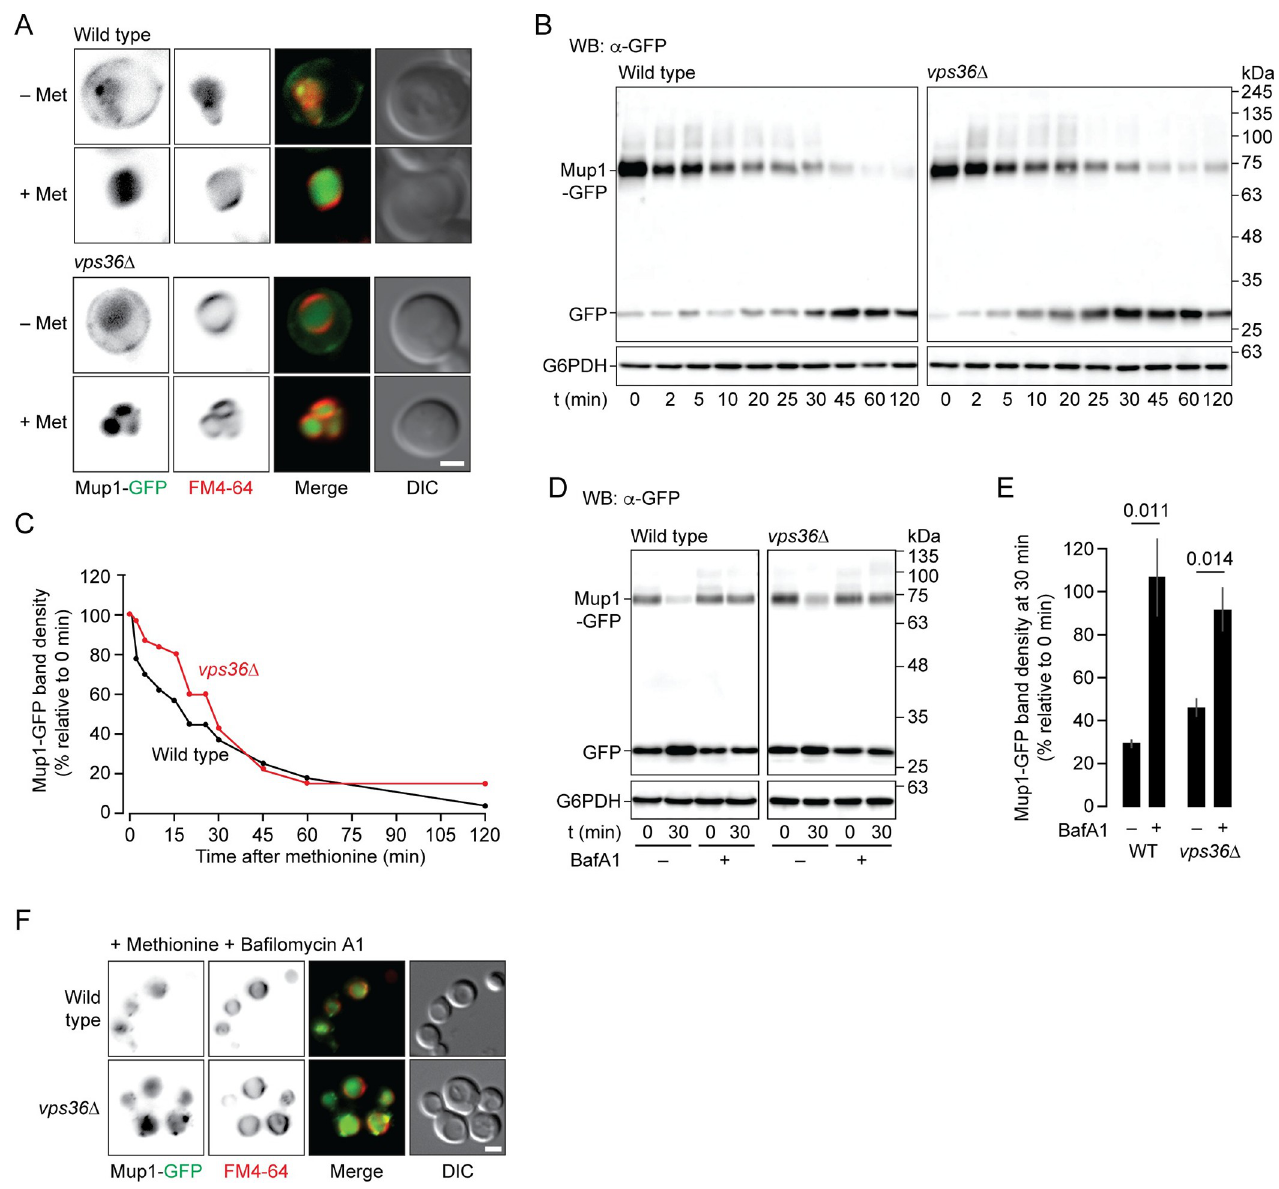
Fig 2. Mup1 is degraded by vacuoles in vps36 Δ cells. (A) Fluorescence and DIC micrographs of live wild type or vps36 Δ cells stained with FM4-64 and expressing Mup1-GFP before or 30 minutes after addition of methionine. (B) Western blot analysis of whole cell lysates prepared from wild type (WT) or vps36 Δ cells expressing Mup1-GFP before (0 minutes) or 5–120 minutes after addition of methionine. Blots were stained for GFP or glucose-6-phosphate dehydrogenase (G6PDH; as load controls). Estimated molecular weights shown. (C) Intact Mup1-GFP band densities relative to 0 minutes and normalized to corresponding G6PDH densities were calculated for each time shown in B. n = 3 for each strain tested. (D) Western blot analysis of whole cell lysates prepared from wild type (WT) or vps36 Δ cells expressing Mup1-GFP before (0 minutes) or 30 minutes after addition of methionine in the presence or absence of 10 μ M bafilomycin A1 (BafA1). Blots were stained for GFP or glucose-6-phosphate dehydrogenase (G6PDH; as load controls). Estimated molecular weights shown. (E) Intact Mup1-GFP band densities at 30 minutes relative to 0 minutes and normalized to corresponding G6PDH densities were calculated for each time shown in D. n = 3 for each strain tested. (F) Fluorescence and DIC micrographs of live wild type or vps36 Δ cells stained with FM4-64 and expressing Mup1-GFP 30 minutes after addition of methionine in the presence of bafilomycin A1. Means ± S.E.M. and results from Student t-test are shown. Cells were stained with FM4-64 to label vacuole membranes. Arrowheads indicate Mup1-GFP or Mup1-pHluorin on vacuole membranes. Scale bars, 2 μ m.